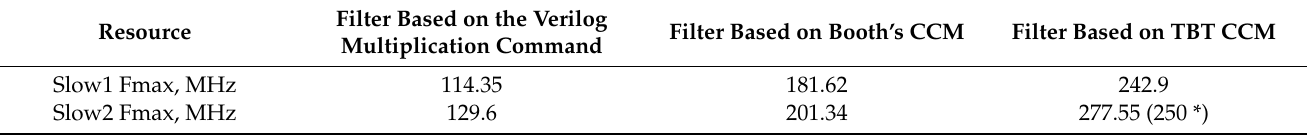
Table 11. Comparison of the frequency characteristics of FIR filter